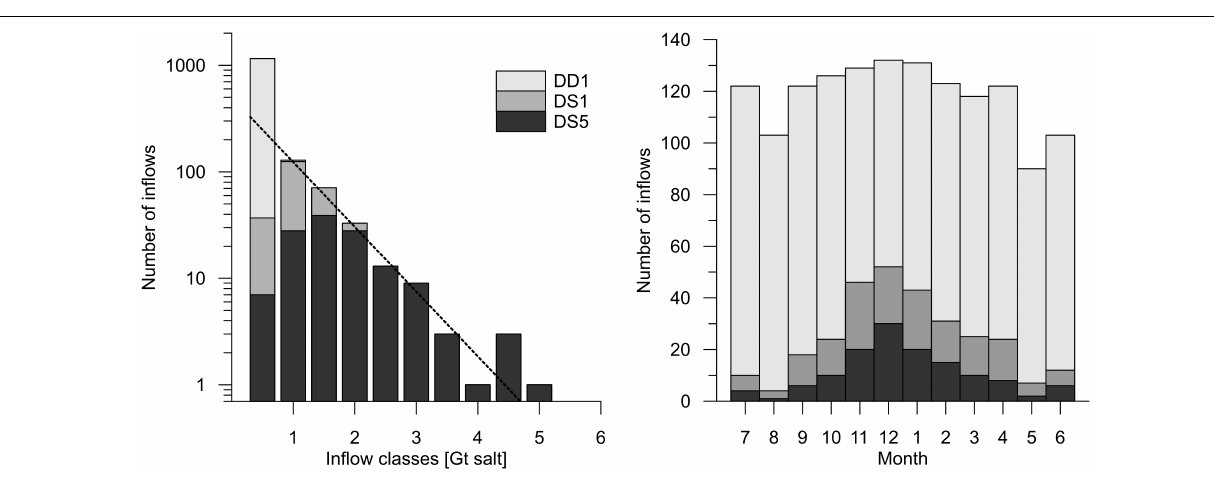
FIGURE 5 | Frequency of inflow events, sorted according their size classes (left) , and monthly distribution of all inflow events (right) of the inflow subsets DD1, DS1, and